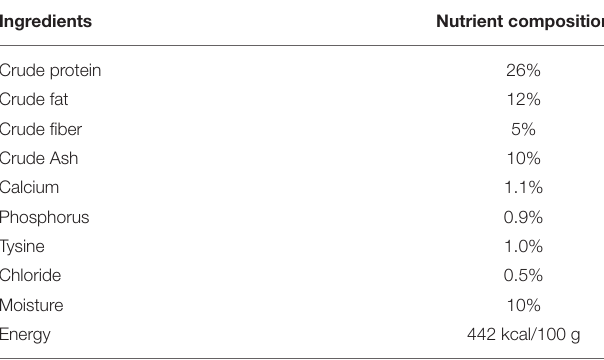
TABLE 1 | Basal characteristics of the enrolled detection dogs. Breed groups